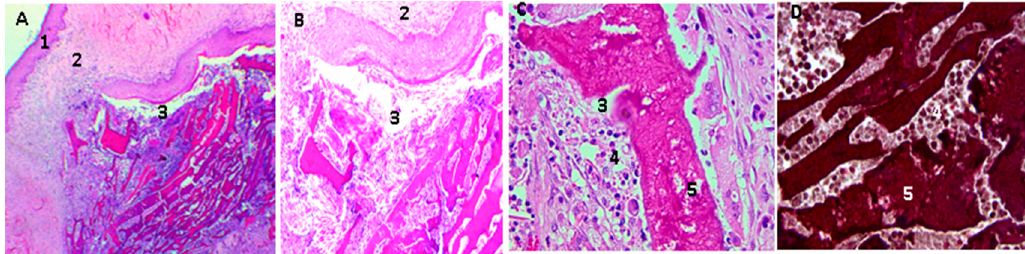
Figure 9. Chitosan/graphene oxide (CS/GO) 0% films implanted in rat skin; in the pictures ( A , B ), movies are seen at 4 × and 10 × , respectively, using the Hematoxylin-Eosin Technique; in the images ( C , D ), at 40 × , the films in the process of and surrounded by a mixed inflammatory infiltrate are observed, the D image is realized using Masson’s Trichromacy technique. 1: epidermis, 2: Dermis. 3: subcutaneous cellular tissue (implantation zone), 4. Mixed inflammatory infiltrates, 5. Scaffolds of CS/GO 0%.